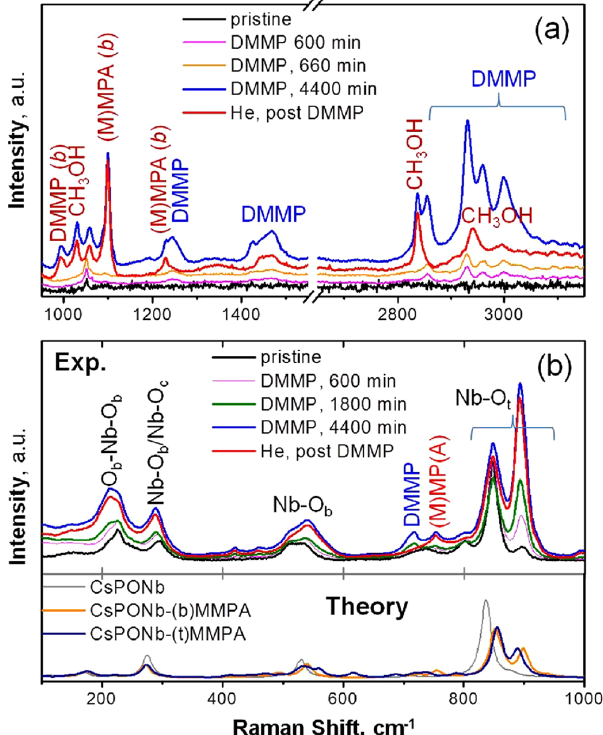
Figure 2. Raman spectra of the reaction system, before reaction (pristine), over the course of stream-feeding of the DMMP/He gas mixture, and in the helium stream following DMMP treatment. ( a ) Spectral region: 950– 1550 cm − 1 and 2650–3150 cm − 1 . ( b ) Spectral region: 100–1000 cm − 1 ; Bottom panel illustrates theory-predicted Raman signatures for the Cs 8 [Nb 6 O 19 ] ( CsPONb ) and Cs 8 [Nb 6 O 19 ] bound to MMPA ( CsPONb -MMPA) at bridging (b) and terminal (t)